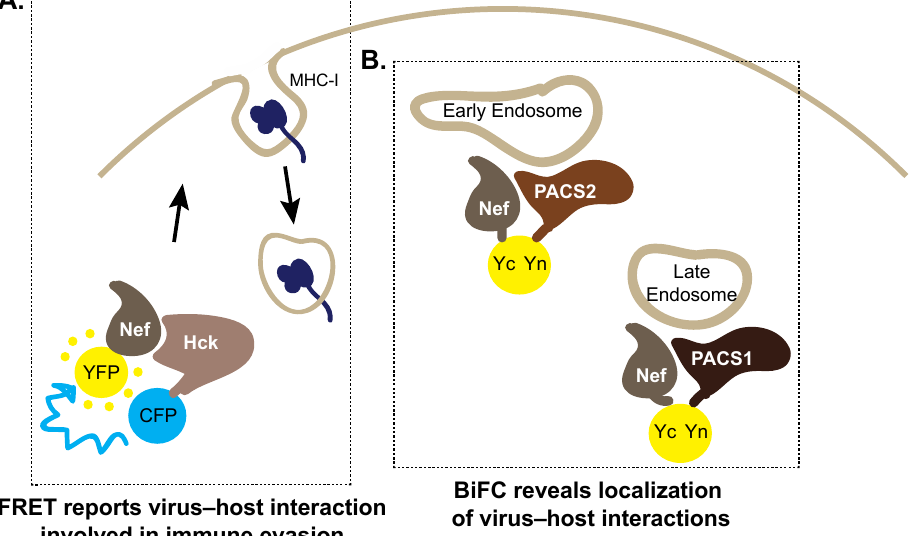
Figure 4. Fluorescence-based methods to monitor virus–host interactions required for the HIV-1 accessory protein negative factor (Nef) to hijack the host cell. ( A ) Key interactions between Nef and the Src-family kinase Hck are detectable in cells by Forster resonance energy transfer (FRET). Co-expression of Hck–CFP ( cyan fluorescent protein) and Nef–YFP ( yellow fluorescent protein) generates a FRET signal demonstrating their interaction. This interaction activates the signaling pathways required to internalize major histocompatability complex-I (MHC-I) from the cell surface to prevent cytotoxic killing of HIV-1 infected cells; ( B ) Bimolecular fluorescence complementation (BiFC) reports the interaction between the PACS1 and PACS2 proteins and Nef, localizing these interactions to early and late endosomal compartments, respectively. Yn: N-terminal of YFP, Yc: C-terminal of YFP, which reconstitute upon protein–protein interactions.